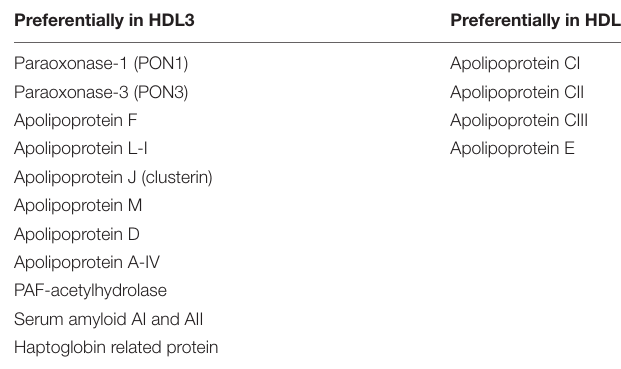
TABLE 1 | Relative distribution of peptides between HDL2 and